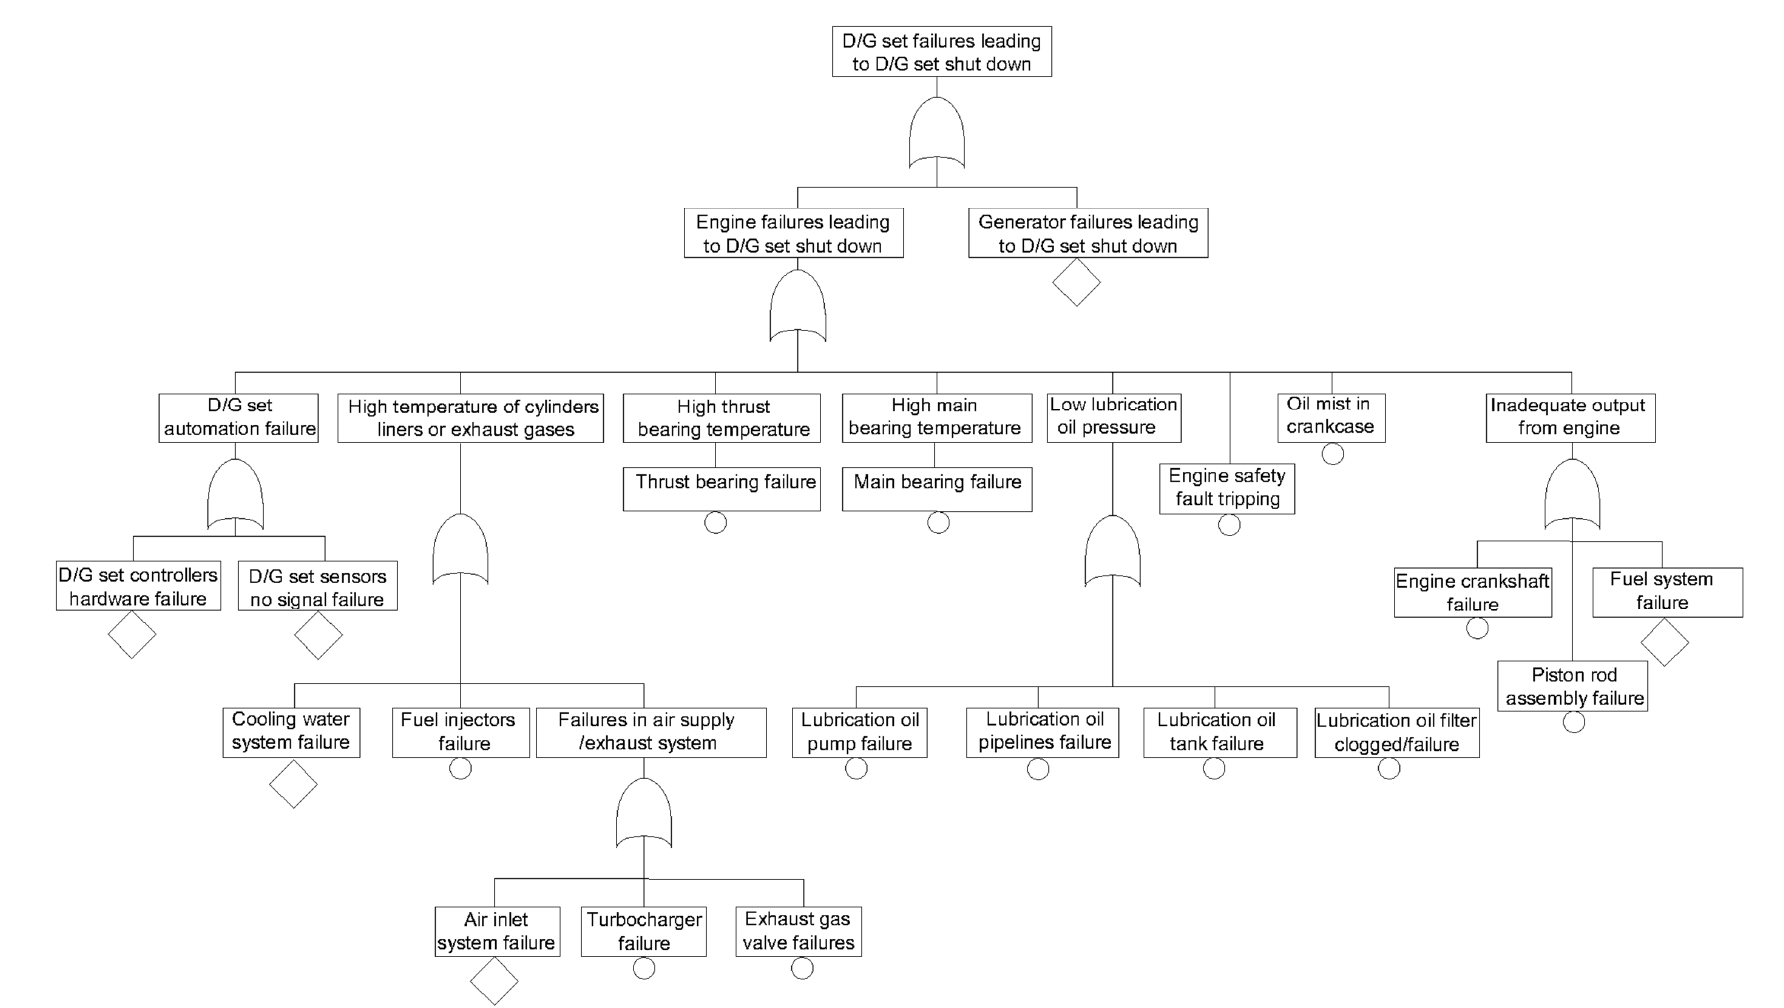
Figure 9. Fault Tree showing the main engine failures leading engine to shut down.